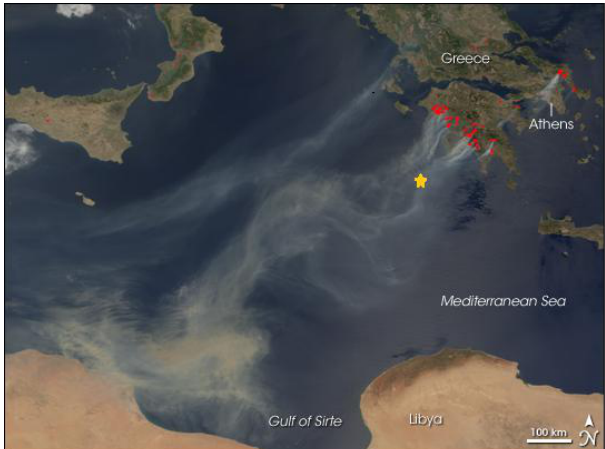
(Figs. 2c–d and 3b), 2 mg m − 2 d − 1 , value which is a factor